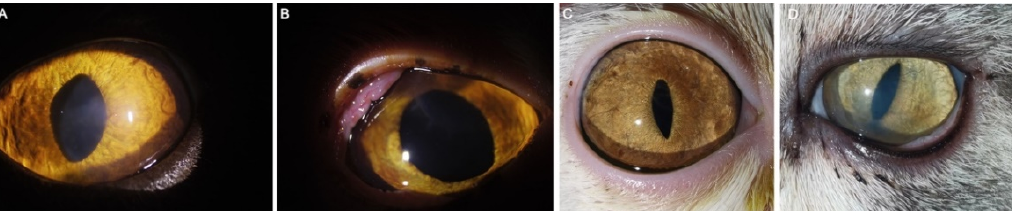
Figure 5. Good and satisfactory examples of functional and cosmetic outcomes. ( A – D ) Case number: 11 (24 months post-op), 26 (14 months post-op), 32 (6 months post-op) and 33 (11 months post-op). Table 1. Grade of transparency of the cornea. Grade Description Number of Eyes Ghost stromal vasculature, almost undetectable corneal opacity, and clear visualization of the posterior segment